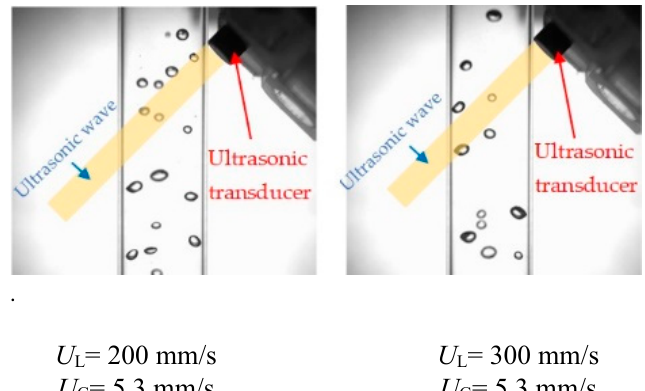
Figure 14. The image of bubble distribution in the two ‐ phase bubbly flow .